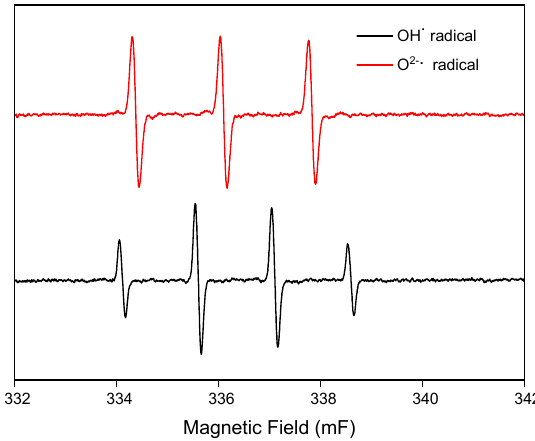
Figure 5. Electron paramagnetic resonance (EPR) representing the presence of · OH and O 2 − .